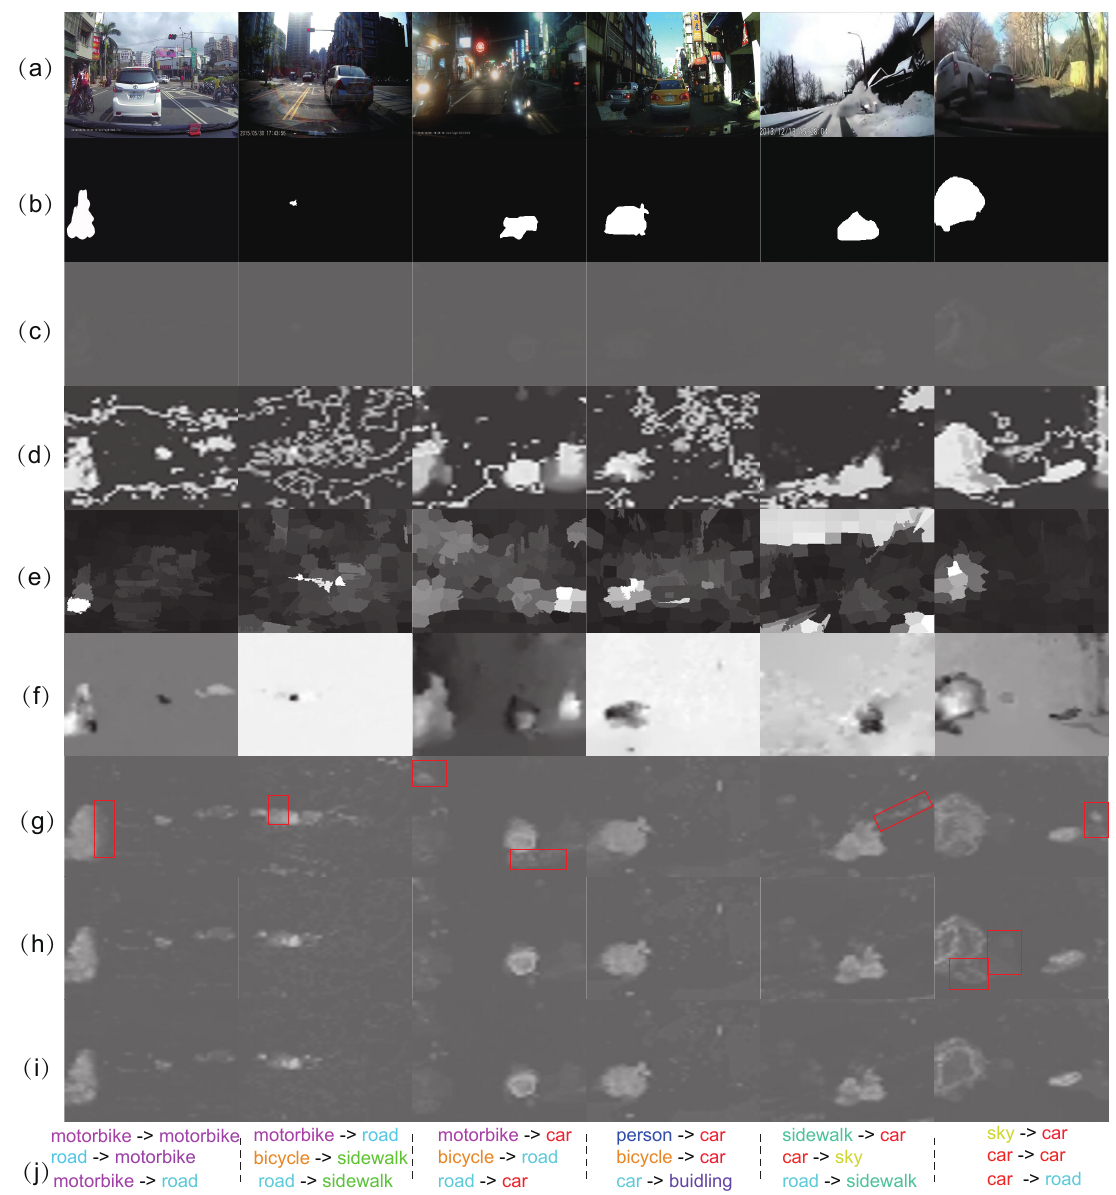
Figure 8. Typical examples for demonstrating the anomaly map by different detectors. ( a ) original frames; ( b ) ground-truth of anomaly regions; ( c ) denotes the results of basic iForest [29]; ( d – f ) represent the results of OC-SVM [49], iGRLSS [37], and RDA [50], respectively. The results of our method are presented by ( g ) our method with only one scale, ( h ) with two scales, and ( i ) with three scales; ( j ) denotes the recounting results of the related